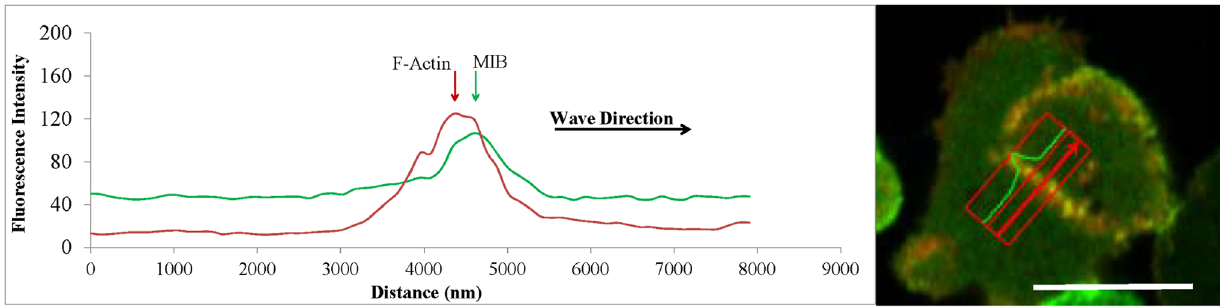
Figure 5. MIB localizes at the front of a moving actin wave in myoB 2 -cells expressing GFP-MIB and mRFP-lifeact. The left panel shows the line scans of the fluorescence intensity of GFP-MIB and mRFP-lifeact of the cell shown in the right panel. The line scans correspond to the boxed area within the cell and the red arrow in the box indicates the direction of scanning. 0 nm in the line scan corresponds to the beginning of the box. The direction of wave movement is indicated in the left panel. Cells were starved for 30 min after which 1 m M latrunculin was added and cell images were recorded. Bar is 10 m m.